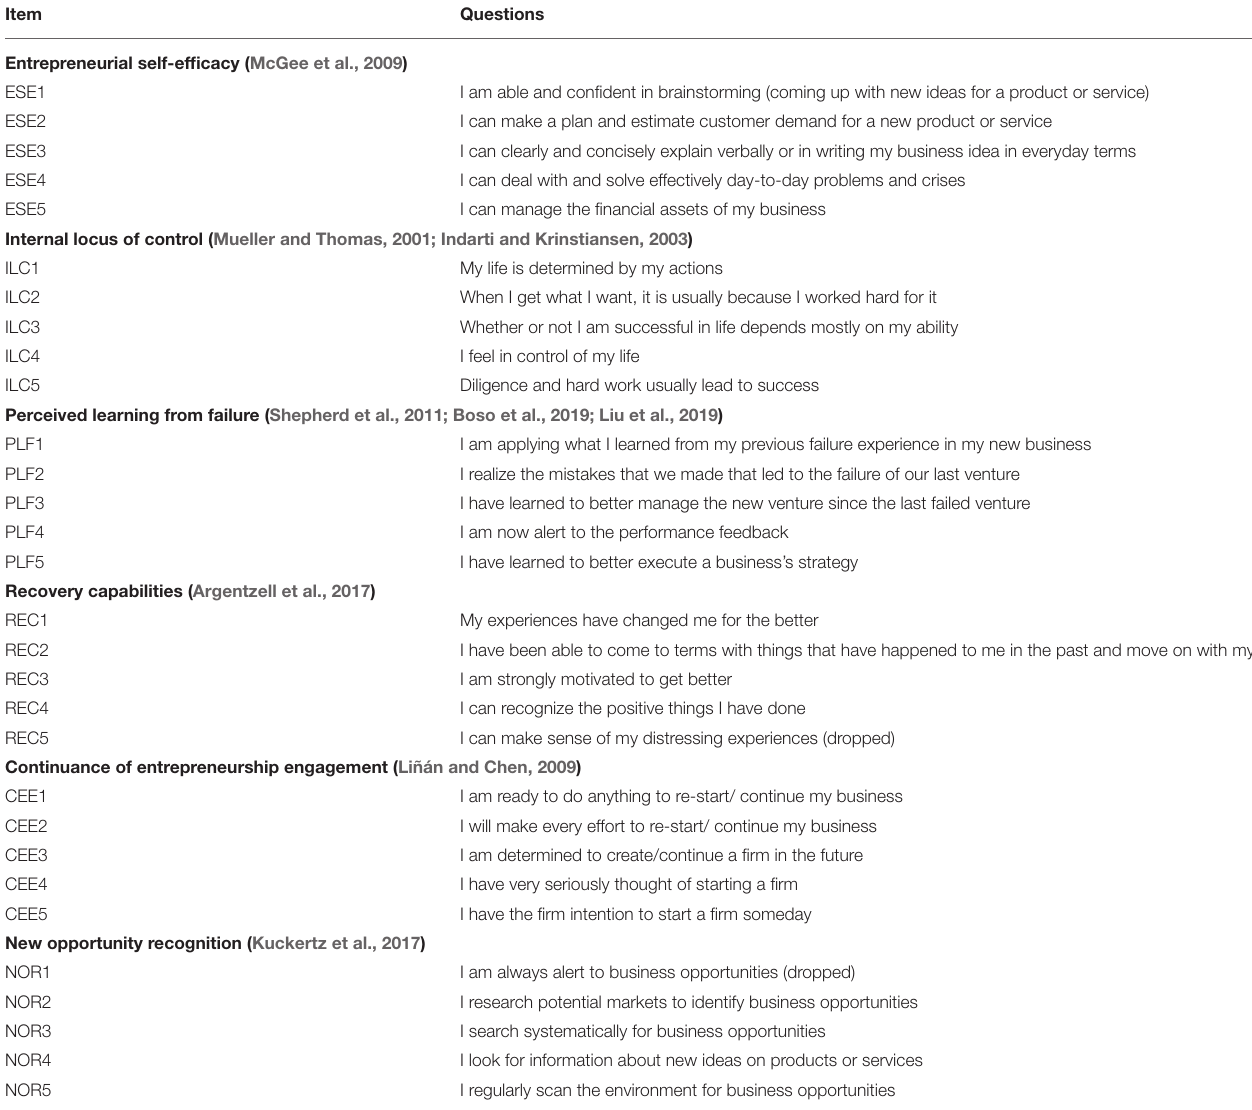
TABLE 2 | Measurement items. Item